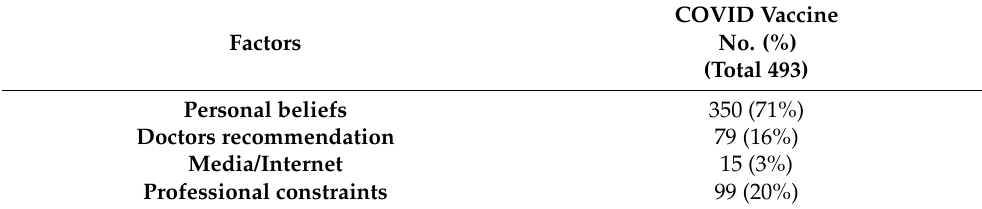
Table 3. Reported sources of information influencing COVID-19 uptake.